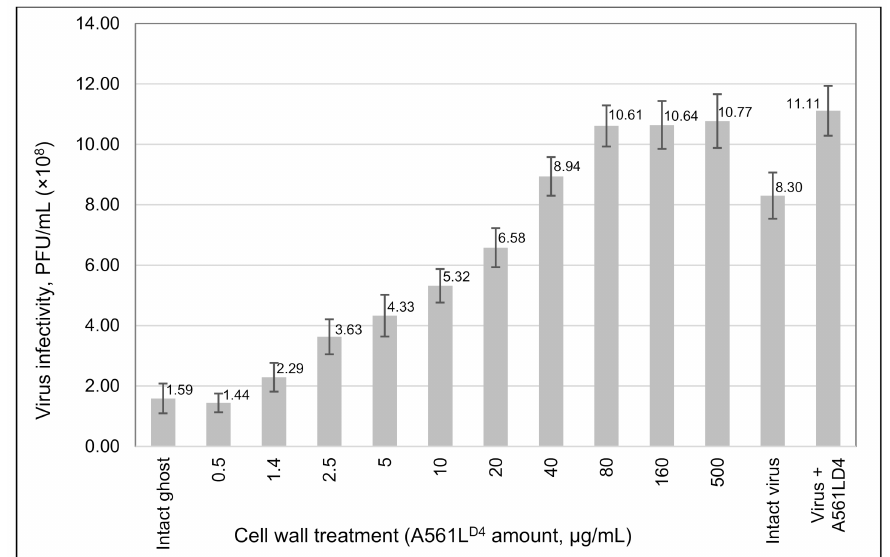
Figure 5. Effect of A561L D4 treatment of C. variabilis ghost cells on PBCV-1 virus receptors. Ghost cells (10 8 cells/mL) in TB with 10 mM CaCl 2 were treated with various amounts of A561L D4 for 24 h. After incubating the ghost cells, the reactions were centrifuged for 15 min at 16,000 × g , (the supernatant fractions were collected for the experiments in Figure 6), and the pelleted cells were washed with TB one time and then re-suspended in 200 µ L of TB with 10 mM CaCl 2 . PBCV-1 virus was added to the treated ghost cells at a MOI of 10 and incubated for 1 h at room temperature. Serial dilutions of the reaction were made and virus infectivity was plaque assayed. Results are plotted as mean ± standard deviation ( n = 10), p -value 0.0001.